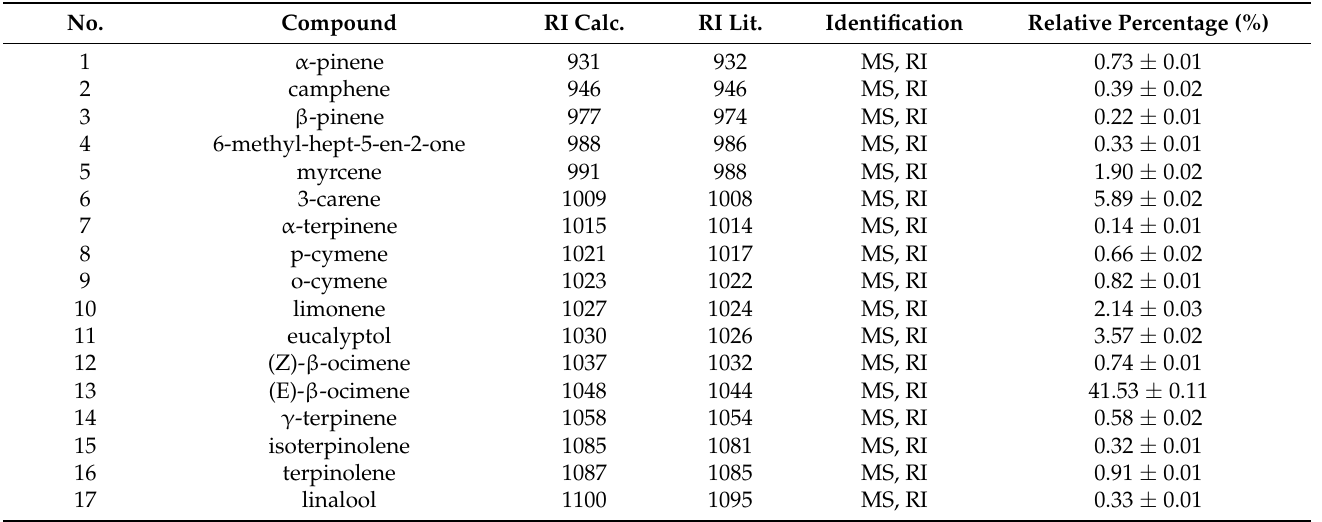
Table 2. Chemical composition of the